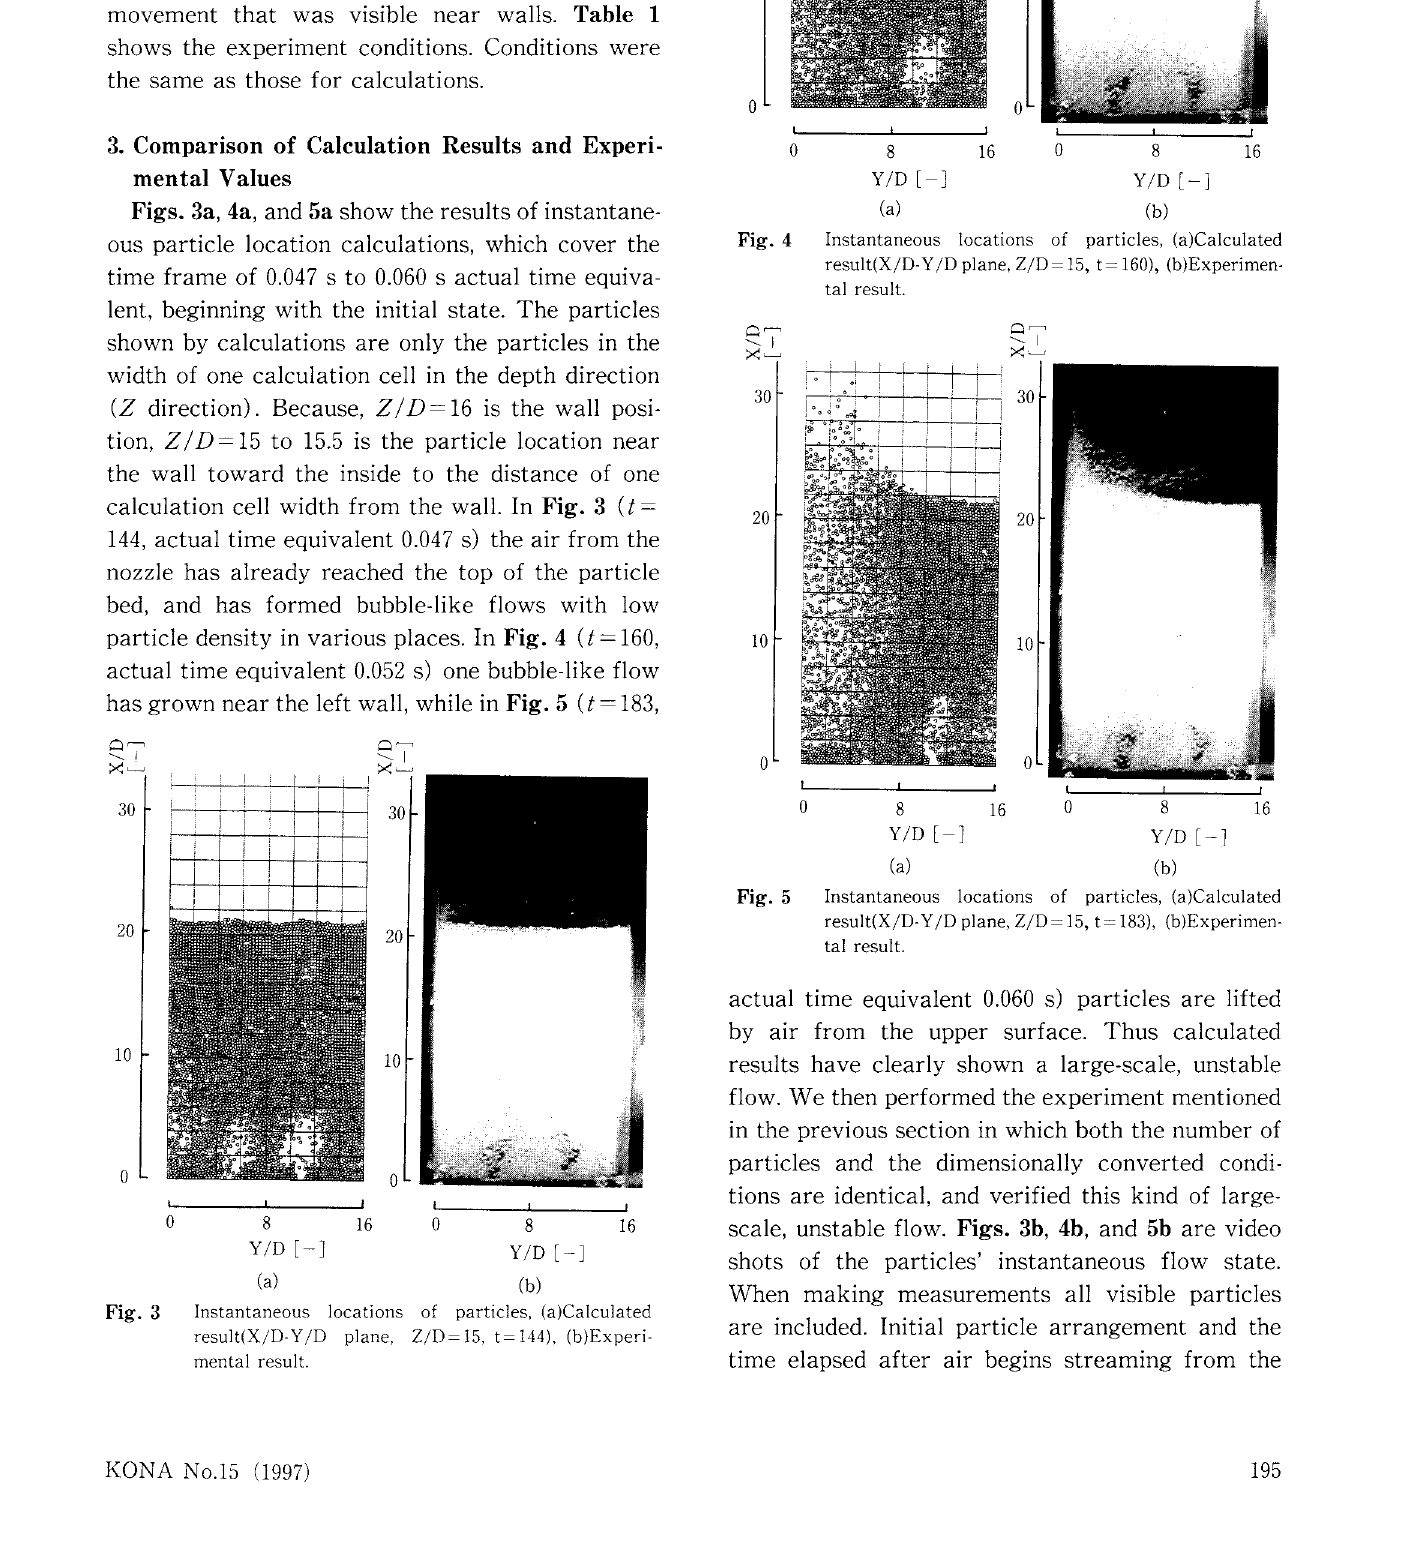
Instantaneous locations of particles, (a)Calculated result(X/0-Y /D plane, Z/D= 15, t= 144). (b)Experi mental result.